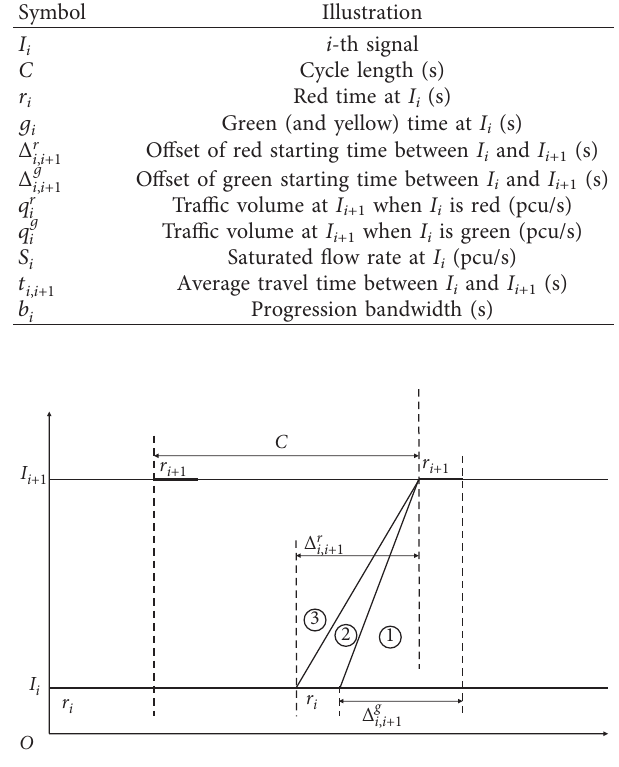
Figure 1: Classification of interlaced spatiotemporal figures according to